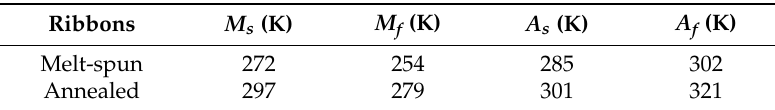
Table 1. Martensitic transformation temperatures ( M s , M f , A s , A f ) for melt-spun and annealed Mn 50 Ni 40.5 In 9.5 ribbons.